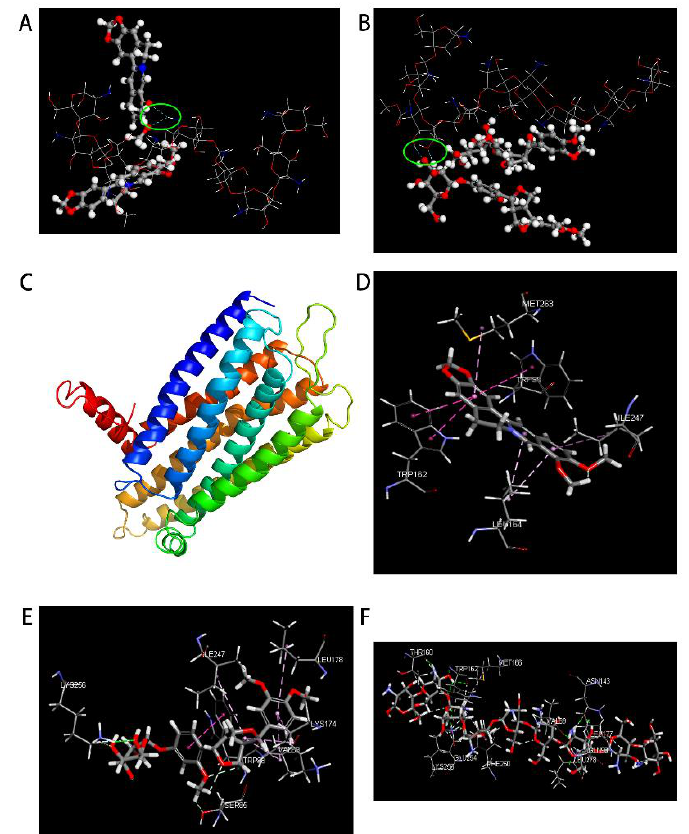
Figure 5. Materials Studio patterns with chitosan of ( A ) BER; ( B ) PHI; ( C ) the predicted model of TAS2R10. Discovery Studio patterns with TAS2R of ( D ) BER; ( E ) PHI; ( F )